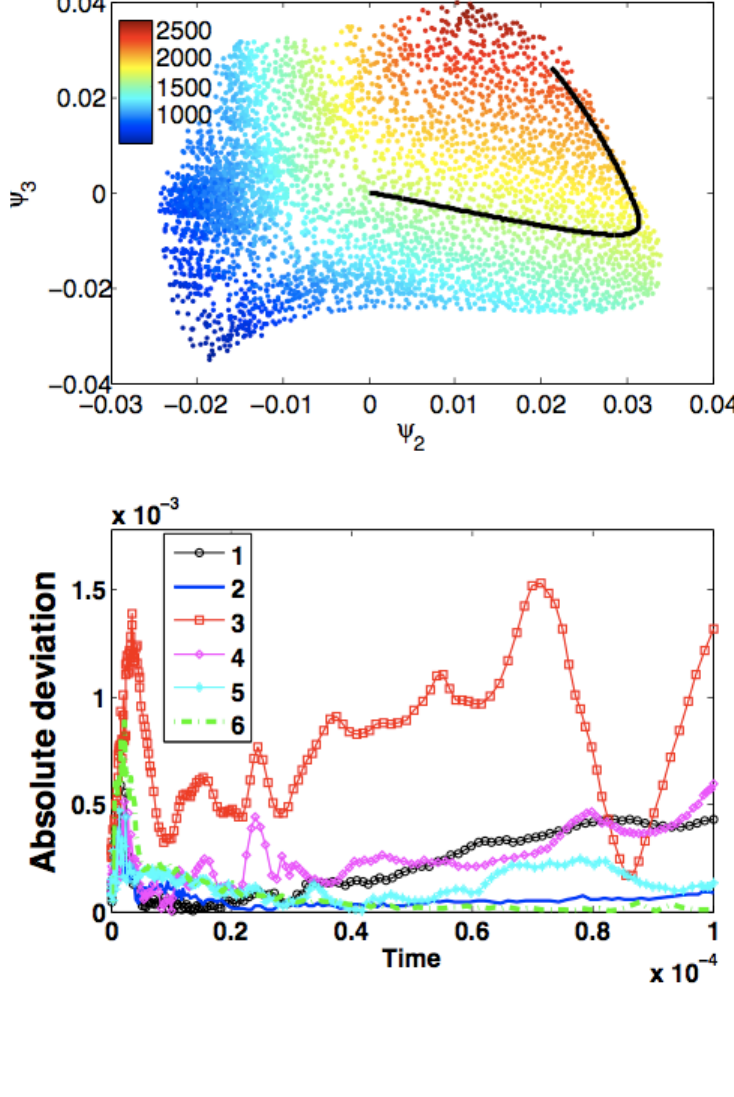
Figure 11. ( Top ) A sample detailed transient solution is shown in the plane, ψ Restriction is done by the Nystr¨om method, while colors refer to the temperature (Kelvin) of the gas mixture; ( Bottom ) Time evolution of the absolute deviation between detailed and reduced solution trajectories (in the reduced space) correspond to the first six methods in Table